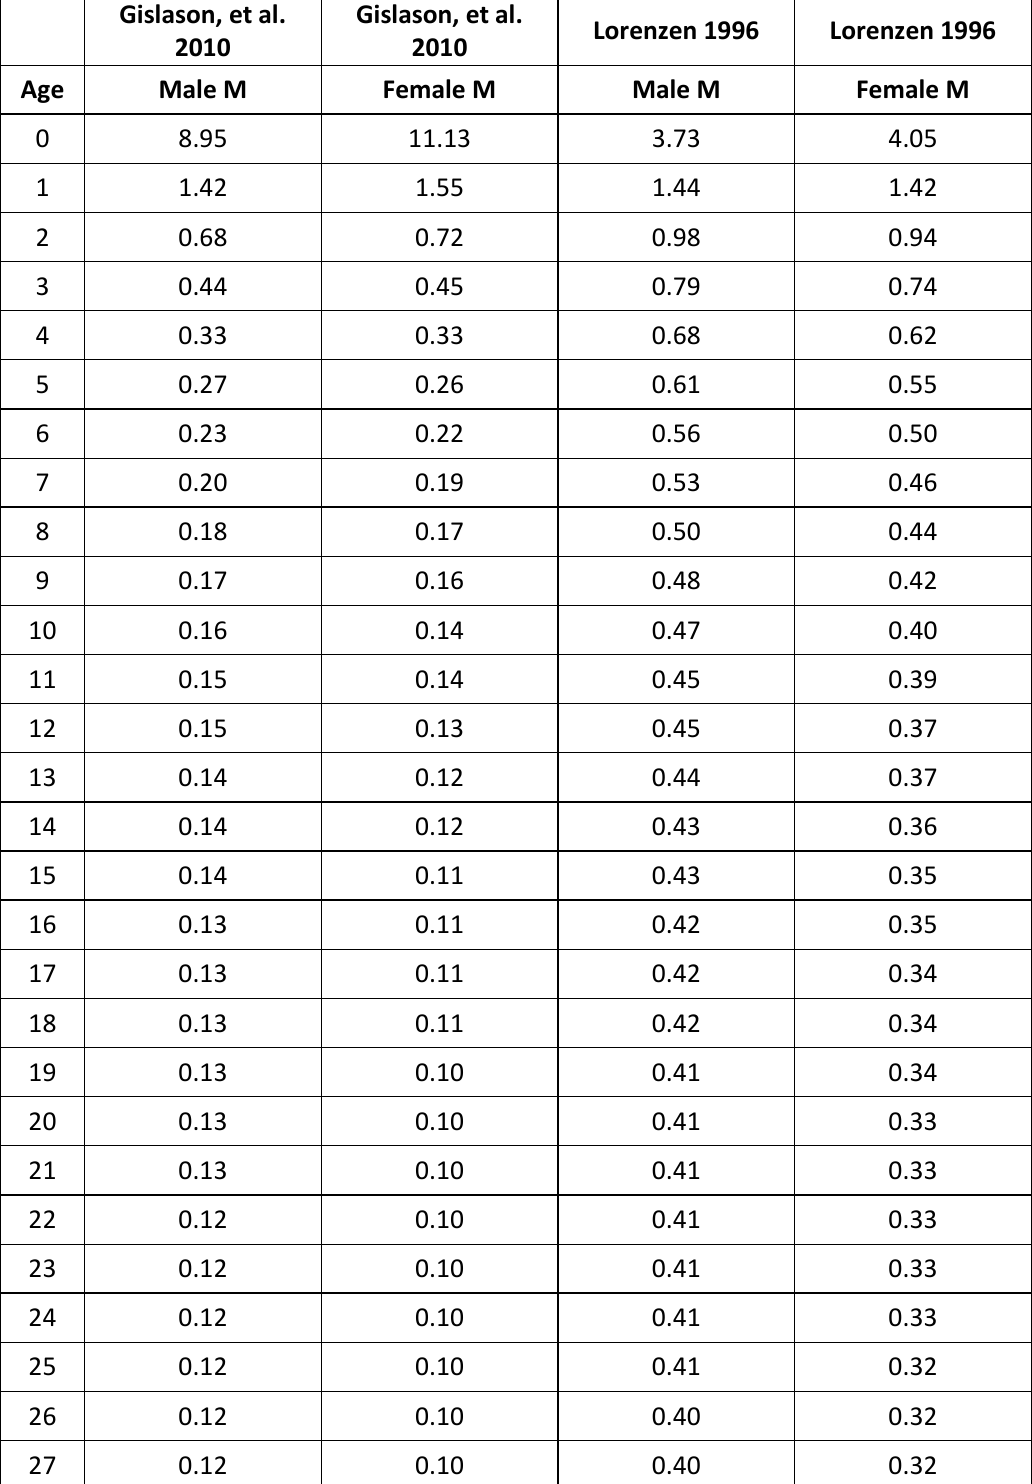
Table 10. Hypothetical instantaneous natural mortality rate schedules for horseshoe crab based on von Bertalanffy